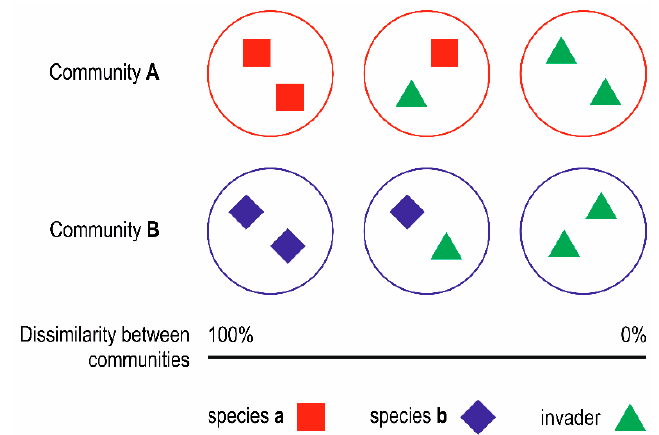
Figure 1. A schematic representation of how an invader may cause biotic homogenization in the recipient communities. Community A is characterized by its exclusive species a, and community B is characterized by its exclusive species b; the two communities are evidently highly dissimilar. If an invasive species enters both communities to flank or even replace the exclusive species, then the two communities become more similar, and hence homogenized.